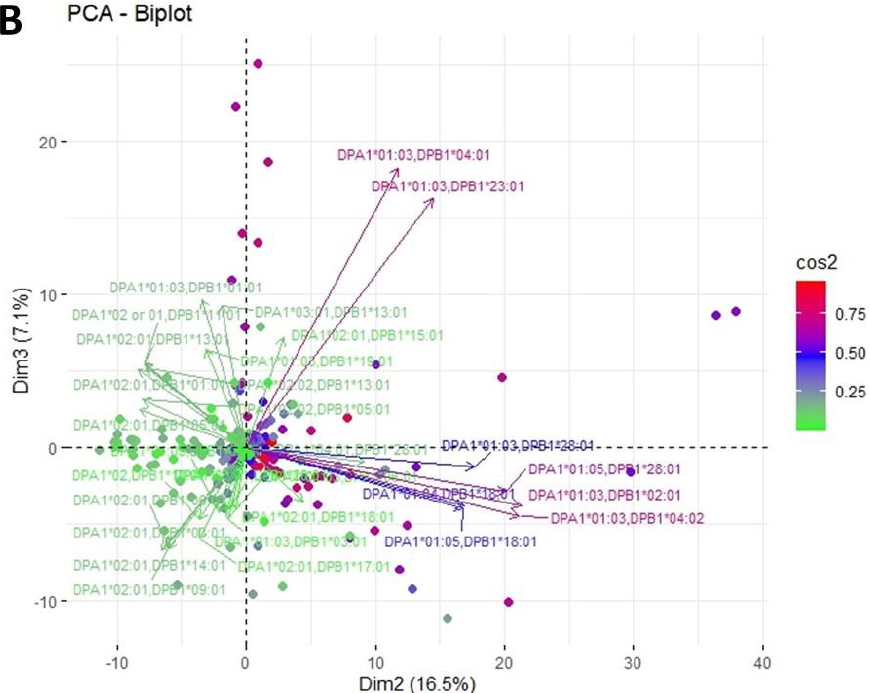
Figure 5. PCA biplot projections of anti-HLA-DP responses. ( A ) Projection of the first and second eigenvectors of the covariance matrix. ( B ) Projection of the second and third eigenvectors of the covariance matrix. Each arrow represents a specific anti-HLA-DR reaction, while each point indicates individual reactions. Colors of loadings and points represent the cos2 value of the explained variance for variables and individuals, respectively.